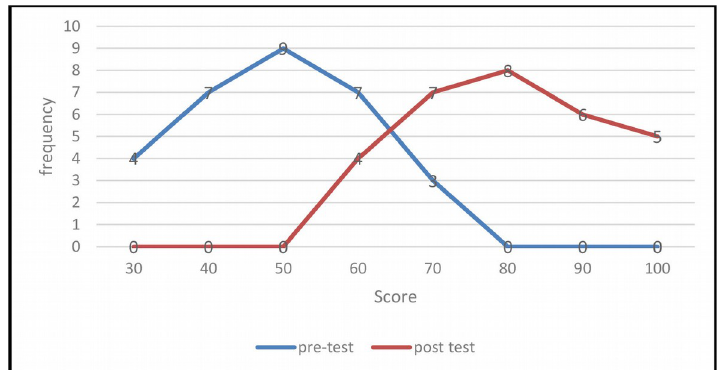
Figure 14. The result of pretest and